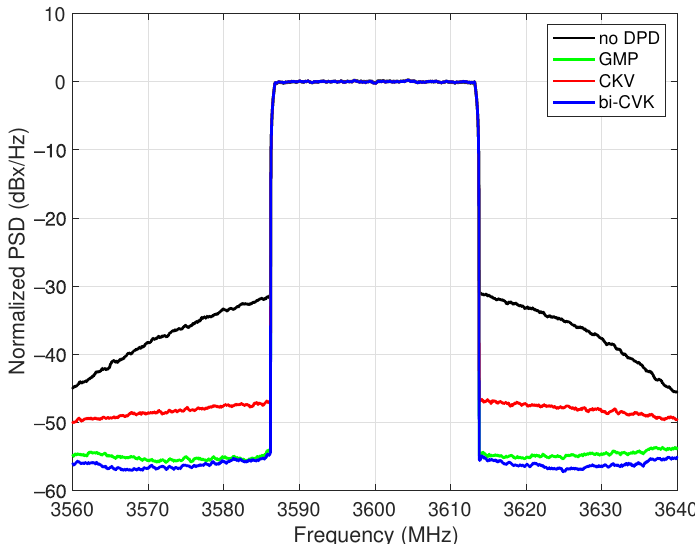
Figure 10. Normalized power spectral densities (PSDs) of the output signal without DPD and with the models in comparison for class AB PA operated at 3.6 GHz with an average output power of 31.2